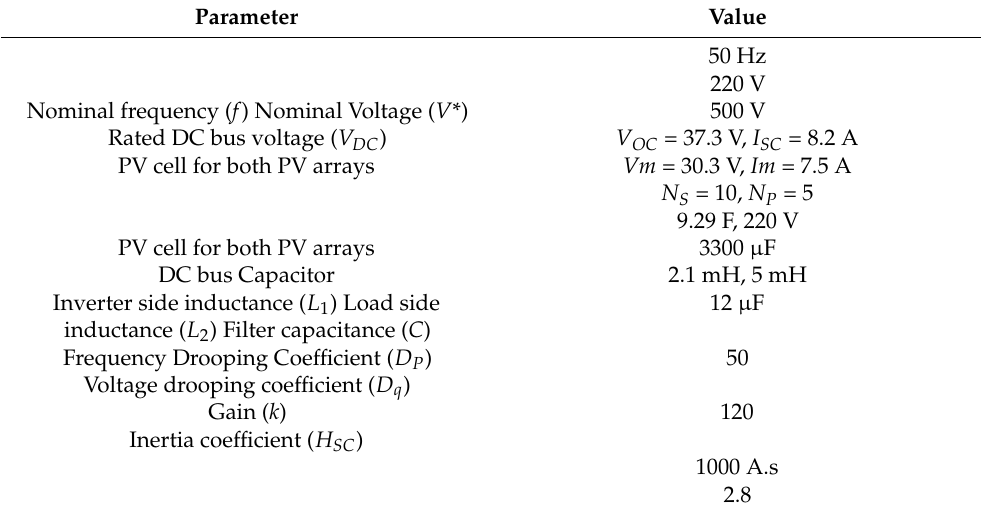
Table 4. Simulation